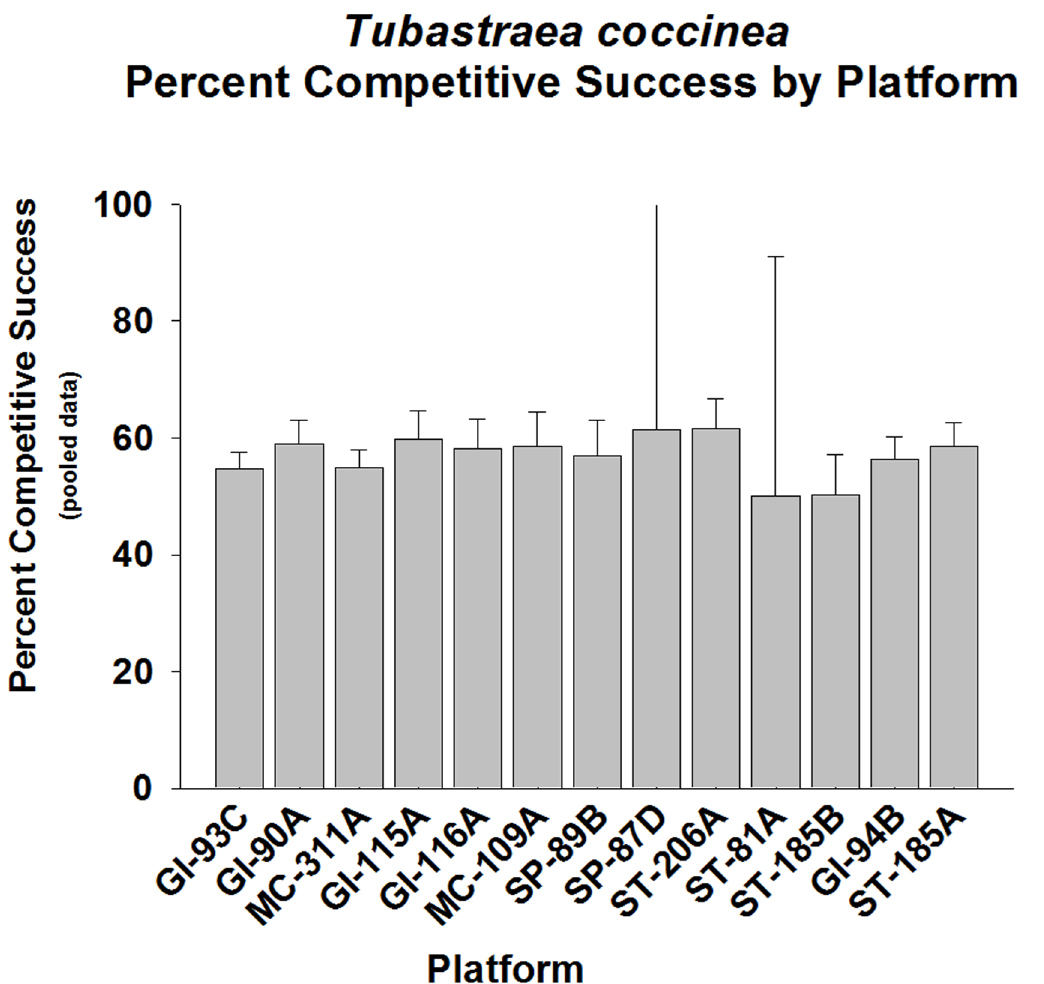
Fig 3. Percent success in competition for space between Tubastraea coccinea and all other sessile epifauna pooled, presented by platform. Mean plus 95% confidence limits shown. Range of number of interactions per platform (n): 217 – 1,283. See Fig 2 legend for additional details. Overall competitive success significantly higher than 50% (p < 0.001, Fisher ’ s Exact Test). Also, almost all platforms exhibited a competitive win frequency significantly higher than 50% (p < 0.01 – 0.001, Goodness of Fit Test, G-statistic), except ST-81A and ST-185B, which exhibited no significant difference from the 50% competitive success level (p >